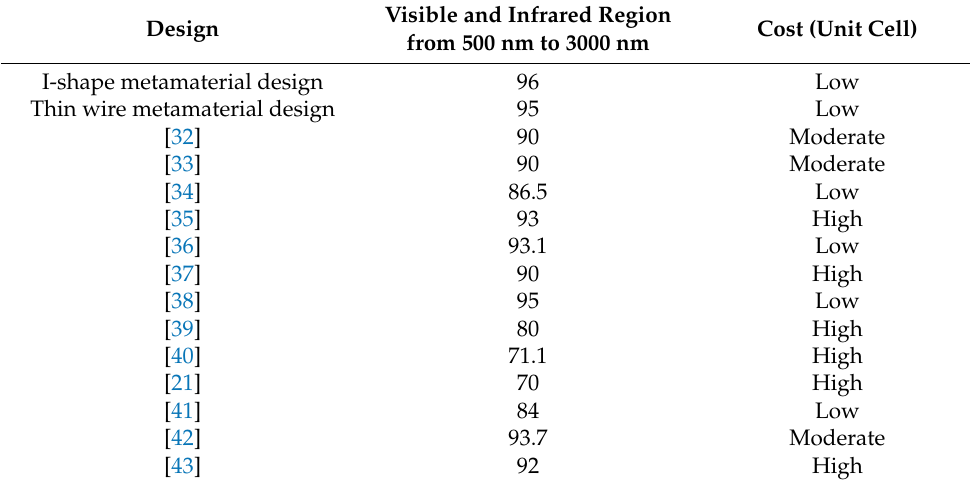
Table 1. Comparison of solar absorber designs with the proposed double substrate design of I-shape metamaterial and thin metamaterial. Visible and Infrared Region Cost (Unit Design from 500 nm to 3000 nm